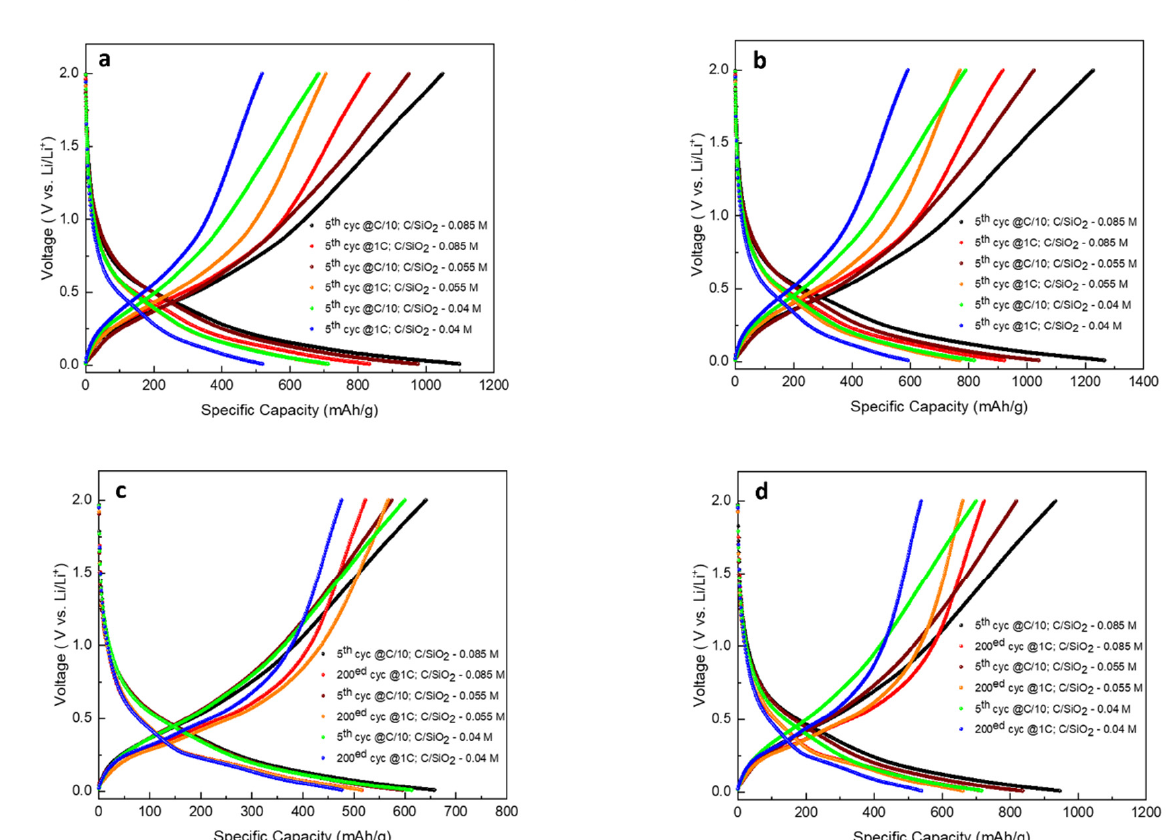
Figure 10. Charge–discharge voltage profiles of ( a , c ) C/SiO 2 -0.04 M, C/SiO 2 -0.055 M, and C/SiO 2 -0.085 M uncalendered electrodes ( b , d ) C/SiO 2 -0.04 M, C/SiO 2 -0.055 M, and C/SiO 2 -0.085 M calendered electrodes, at different cycles and C rates.